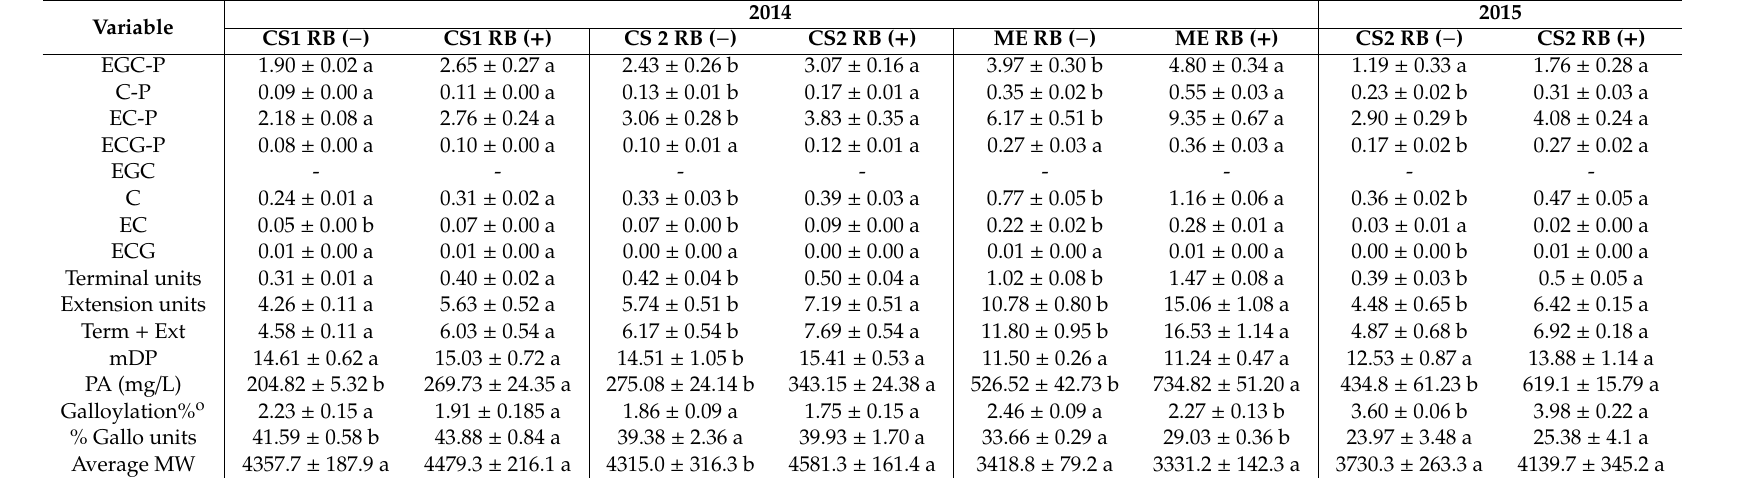
Table 4. Proanthocyanidin (PA) composition of RB ( − ) and RB ( + ) wines in 2014 and 2015